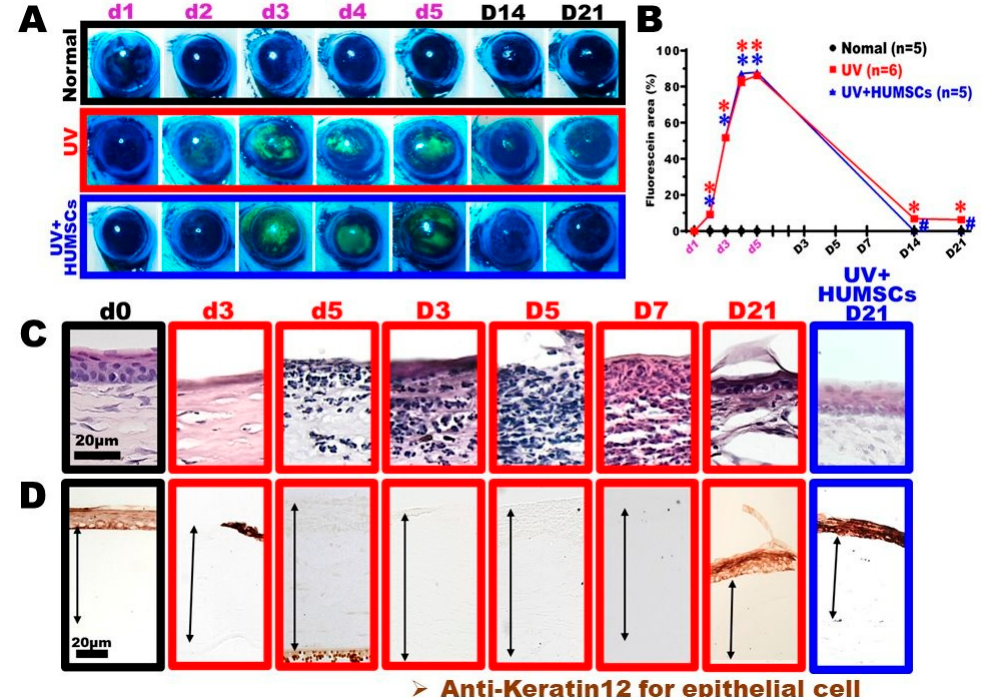
Figure 3. HUMSCs transplantation diminishes corneal epithelial disorganizations following UV irradiation. Corneal fluorescein staining and quantitative analyses of corneal integrity were conducted. The corneal surface was intact, and no staining of fluorescein was observed in the Normal group. UVB irradiation caused serious damage to the corneal tissues, including deteriorated smoothness and staining with fluorescein ( A , B ). Corneal sections were stained with hematoxylin ( C ) and anti-keratin-12 ( D ) and indicated the presence of the corneal epithelium. Anterior epithelial detachment and pseudo-keratinization were observed in the rats of the UV group. In contrast, a significant enhancement of the corneal epithelial organization was detected in the UV + HUMSC group rats. The animal number per group is shown in the figure. * vs. the Normal group simultaneously, p < 0.05; # vs. the UV group at the same time, p < 0.05.